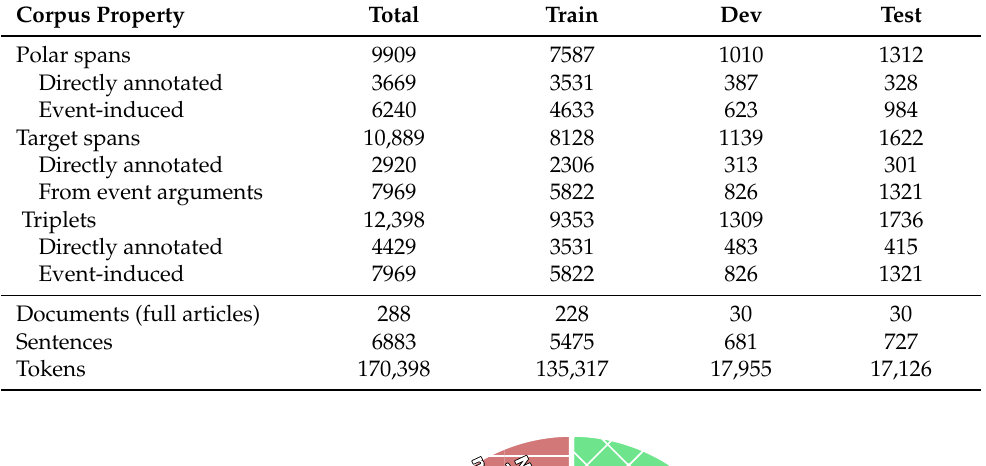
Table 1. Properties and annotation counts for the total corpus and training, development, and holdout test sets.